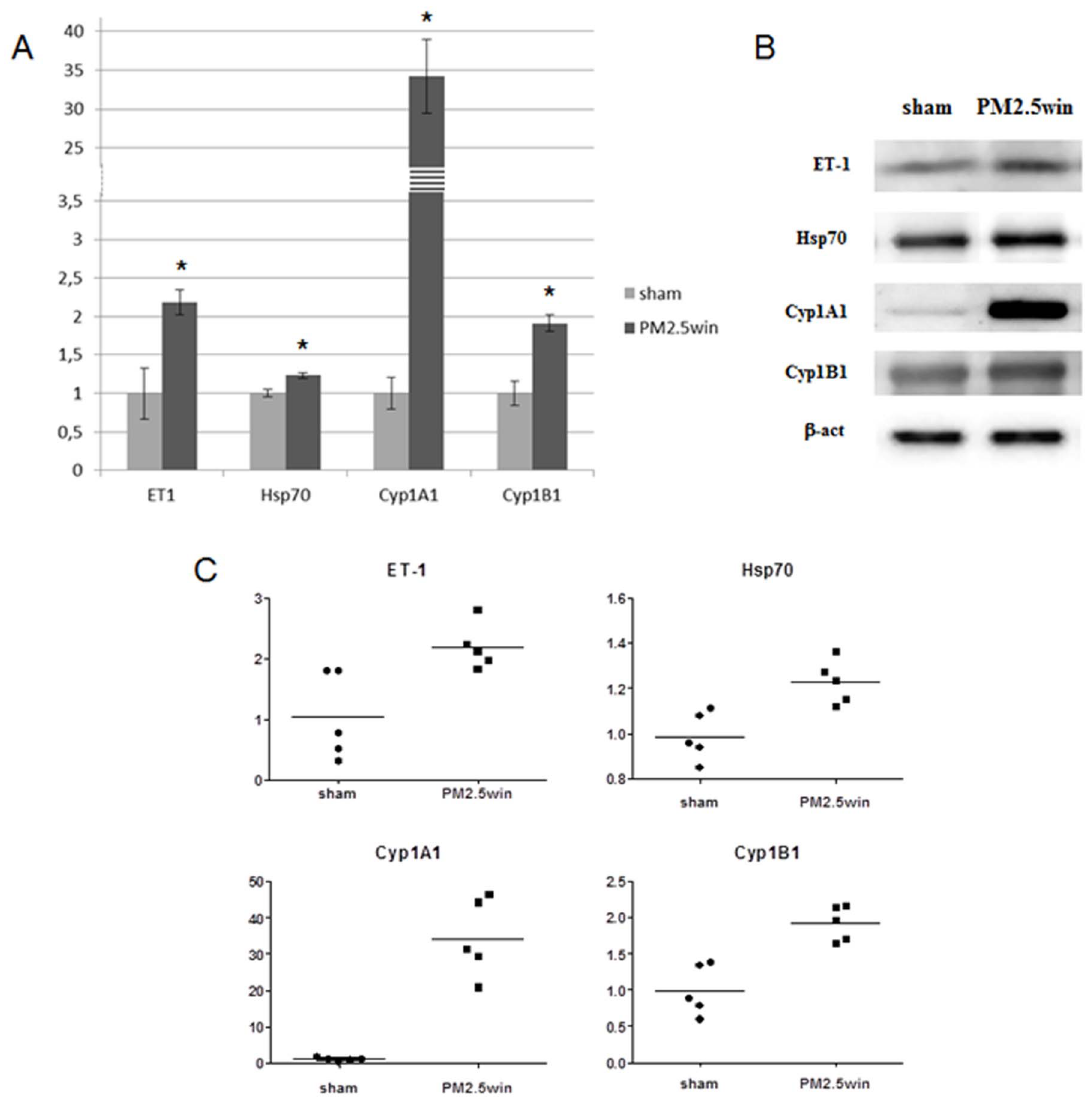
Figure 1. Lung protein analyses. (A) and (B): histograms and representative immunoblottings showing mean 6 standard error of ET-1, Hsp70, Cyp1A1, Cyp1B1 in lung parenchyma of sham (n=5) and PM2.5win-treated (n=5) mice. (C): graphs showing variability among individual animals in significant markers analyzed in lung parenchyma.